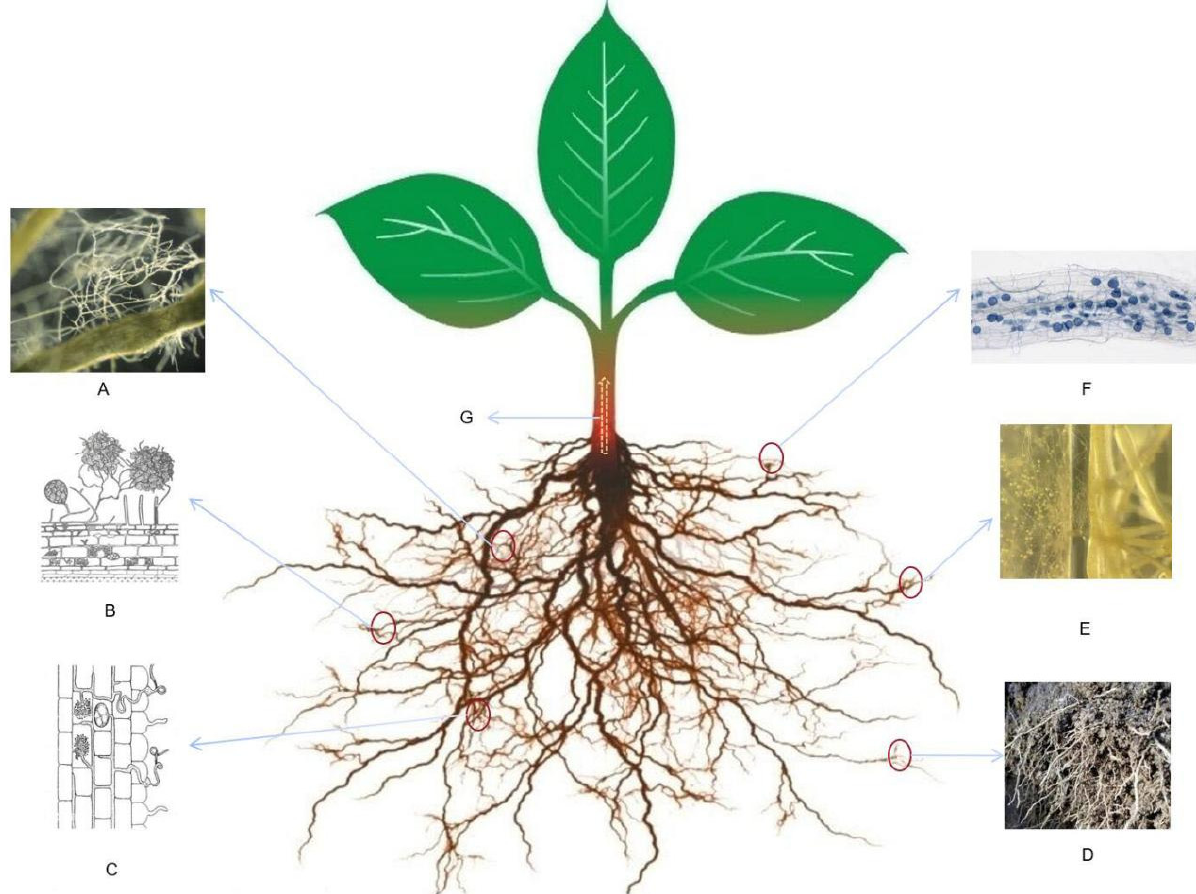
Figure 2. Schematic diagram of biological control mechanisms in arbuscular mycorrhizal fungi (AMF) symbiosis with plants ( A ) Increased root branching and lignified cell walls; ( B ) AMF mycelial network acts as a barrier in root epidermis; ( C ) AMF binds pathogens to the cell wall; ( D ) improve soil structure; ( E ) root exudates kill pathogens; ( F ) AMF stimulates the growth and reproduction of beneficial microorganisms. ( G ) AMF improves the absorption of nutrients and water by plants, while competing with pathogens for nutrients.